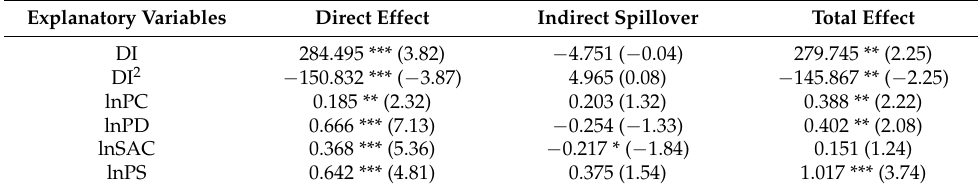
Table 6. SDM model spatial spillover effect